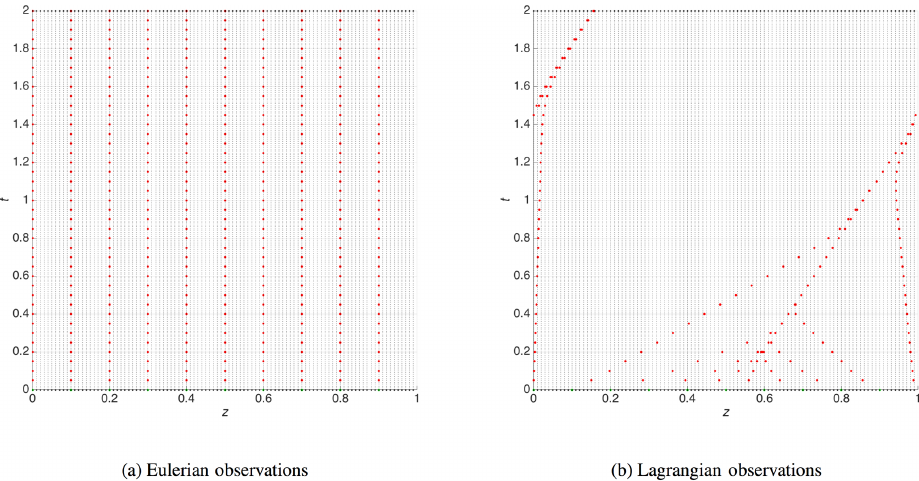
Figure 6. Observations sampled from the BGM nature run (see Fig. 5a) in Eulerian (a) and Lagrangian (b) manner, mimicking geostationary satellite and buoy measurements,